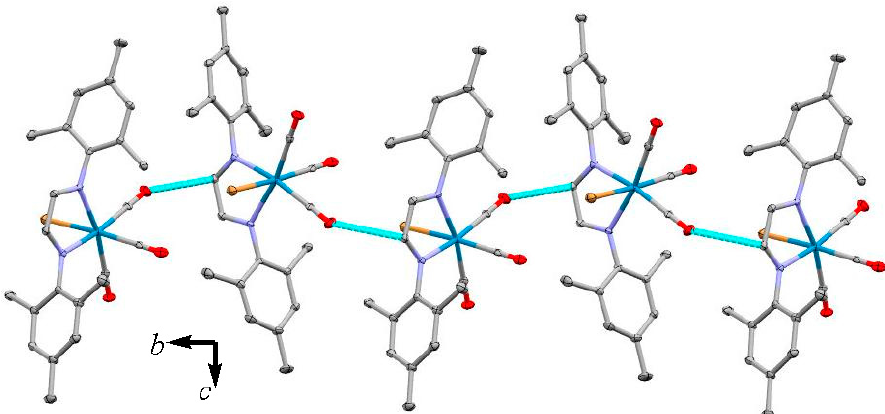
Figure 3. Part of the crystal packing of 3 , showing one-dimensional extended chain formation along the b -axis through intermolecular n → π * interaction (H atoms omitted for clarity).